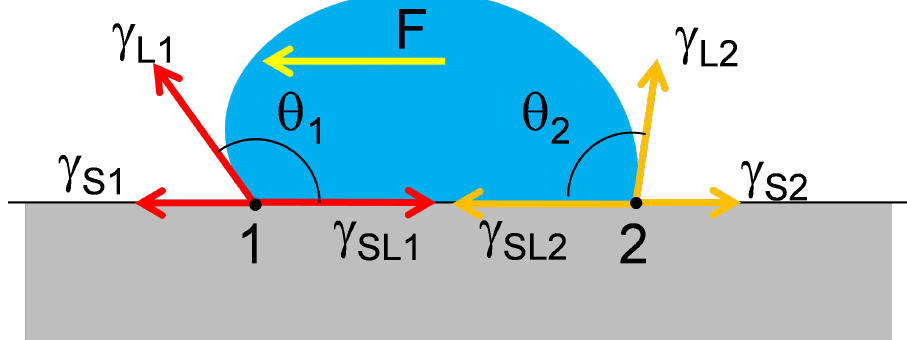
Figure 3. Schematic description of a water drop on a solid